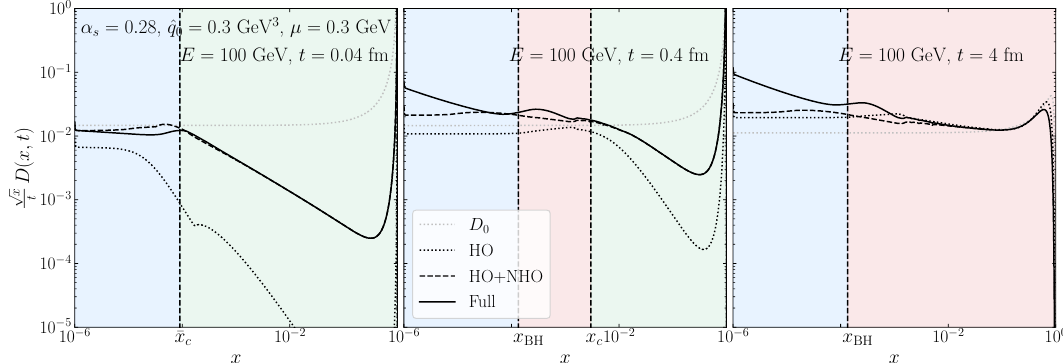
Figure 10 . The energy distribution solution of the medium-induced emission evolution eq. (4.8) at different times (different panels) and using different scattering mechanisms to calculate the emission rate in eq. (4.9) (different line styles). The vertical dashed lines and the shaded areas separate different scattering regions, where on the first panel t < λ and on the last panel t > L c